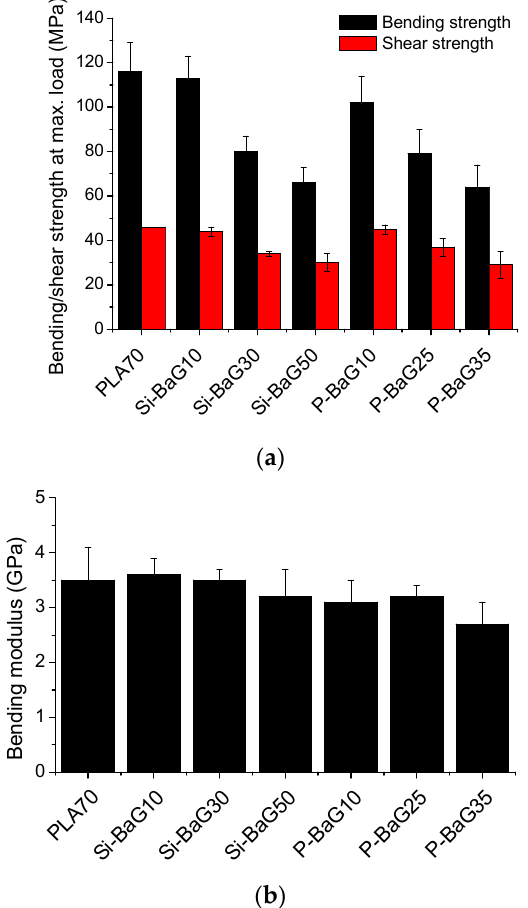
Figure 2. The initial ( a ) bending and shear strength and ( b ) bending modulus of PLA70 and its composites with Si-BaG and P-BaG. The initial bending strength of PLA70 was 116 ± 13 MPa, shear strength 46 ± 0.2